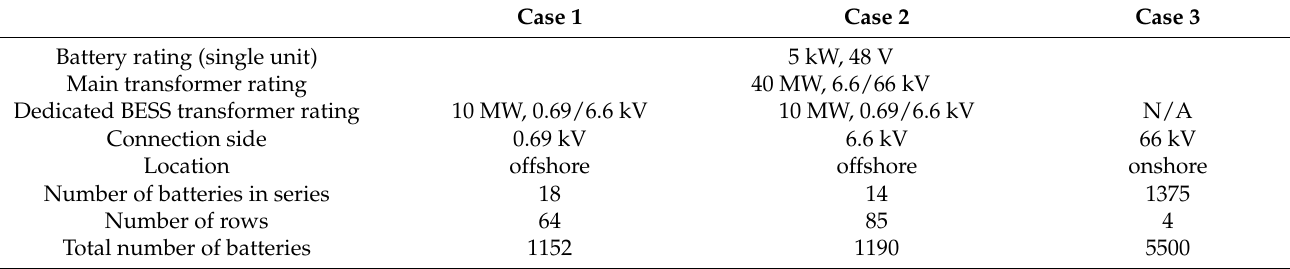
Table 5. BESS sizing with different string arrangements .